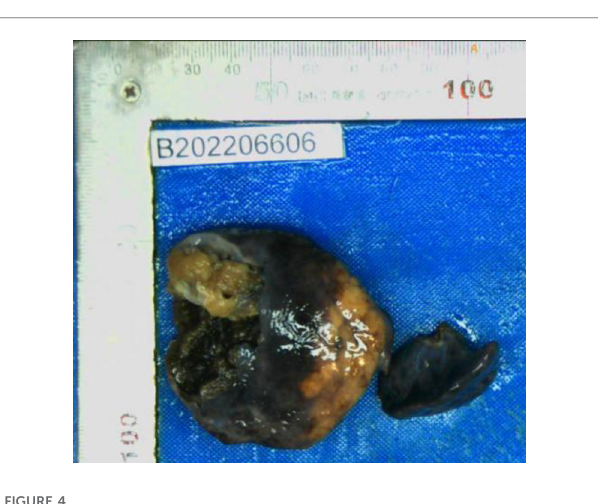
FIGURE 4 Macroscopic examination showing a spongy mass with cystic